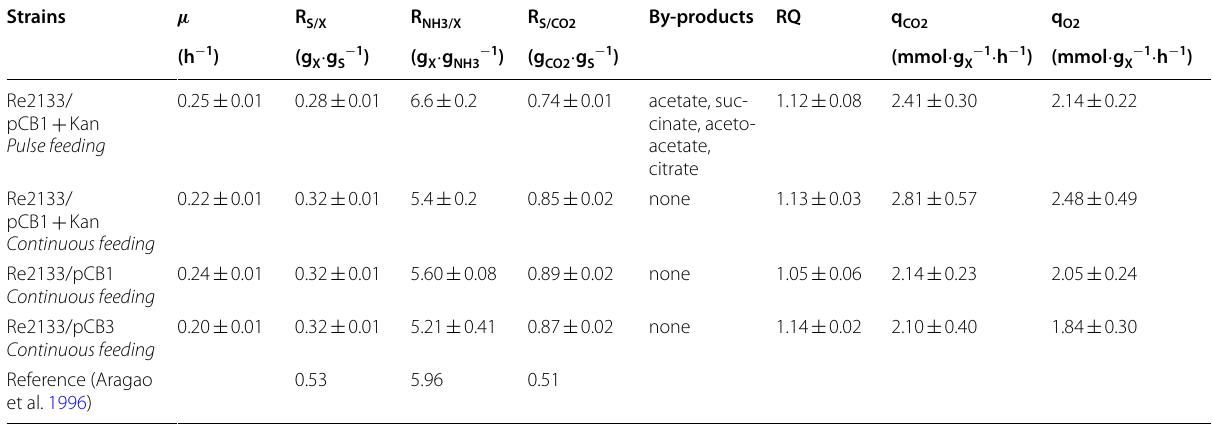
Table 1 Summary of macroscopic data for the strains Re2133/pCB1 (with or without kanamycin; with pulse or continuous fructose feeding) and pCB3